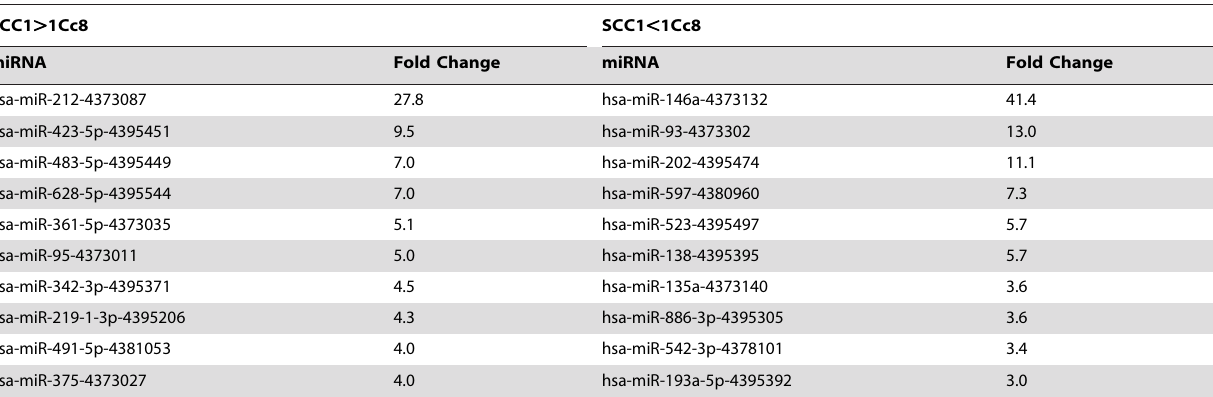
SCC1: cetuximab-sensitive cell line. 1Cc8: cetuximab -resistant cell line.